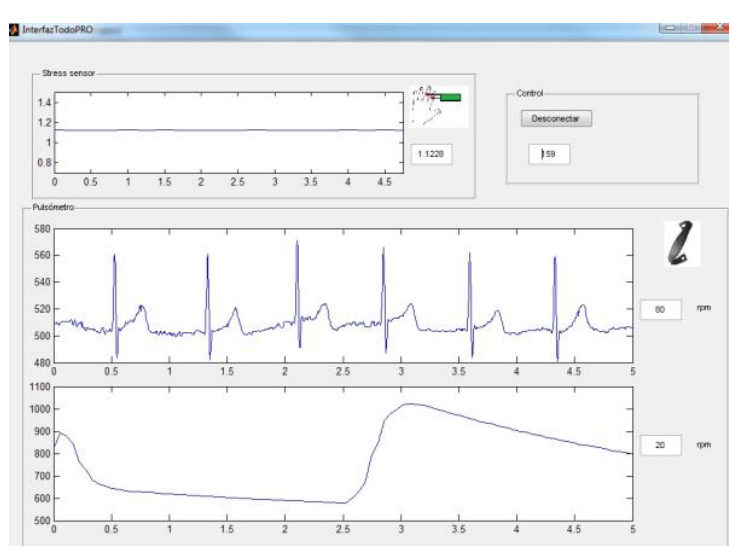
Figure 9. User’s